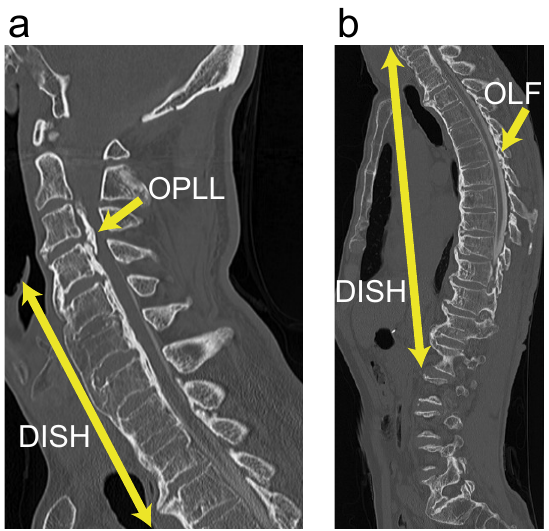
Figure 7. Illustrative case of grade 3 DISH. ( a ) Sagittal cervical CT imaging; ( b ) Sagittal thoracolum- bar CT imaging. CT, computed tomography; DISH, diffuse idiopathic skeletal hyperostosis; OLF, ossification of the ligamentum flavum; OPLL, ossification of the posterior longitudinal ligament.